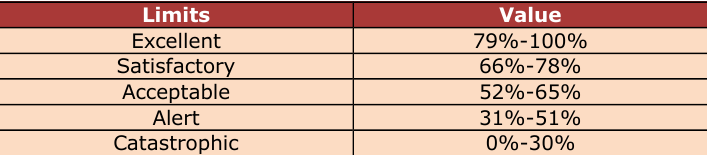
Table 6. Limit values between states in environmental management criterion